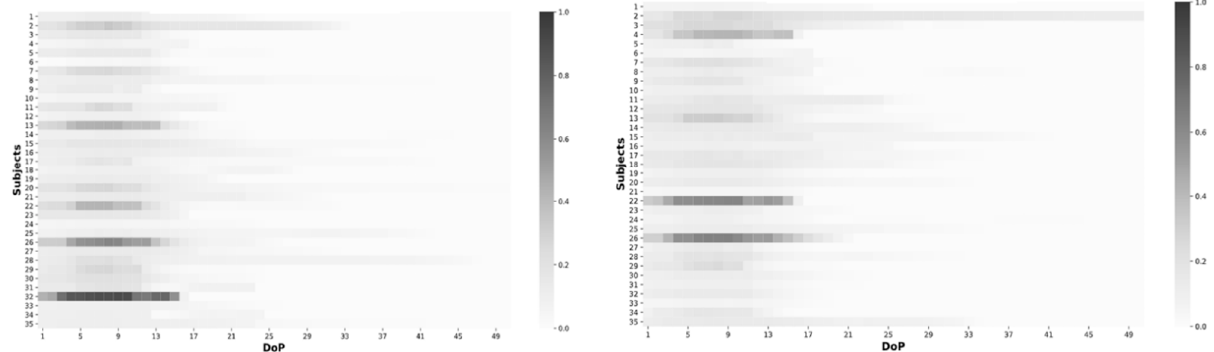
Figure 8. Heatmap distribution of PJ DoP by each subject for all 35 subjects. Left wrist ( left ) and right wrist ( right ).